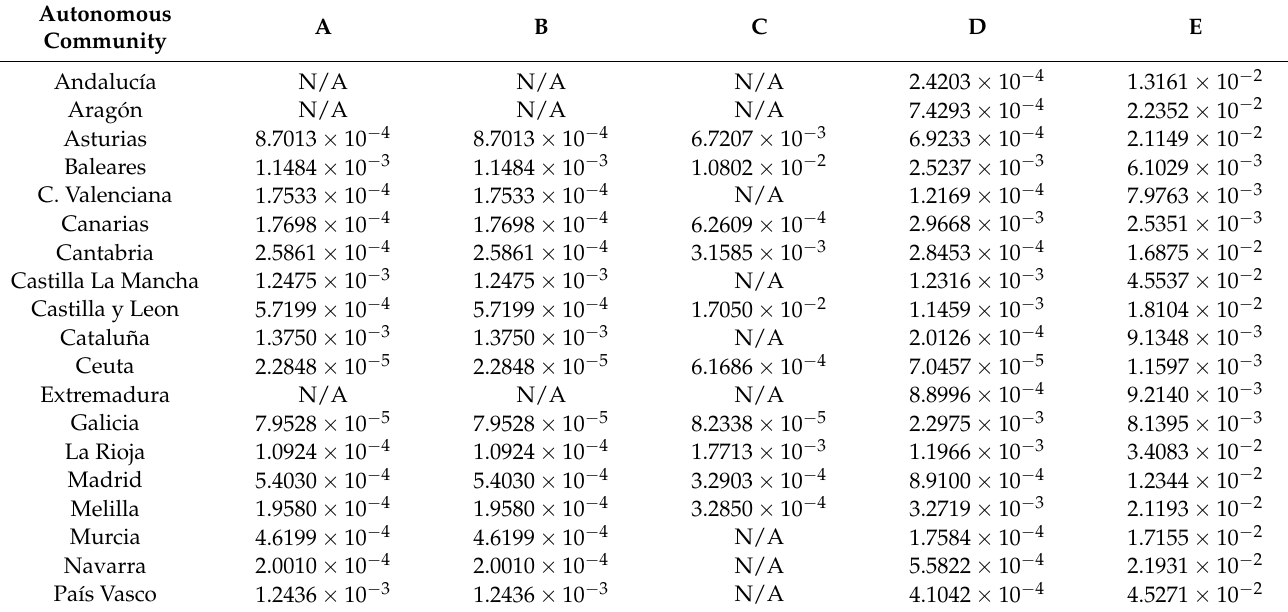
Table A3. Numerical simulation errors (RSME) per Autonomous Community.